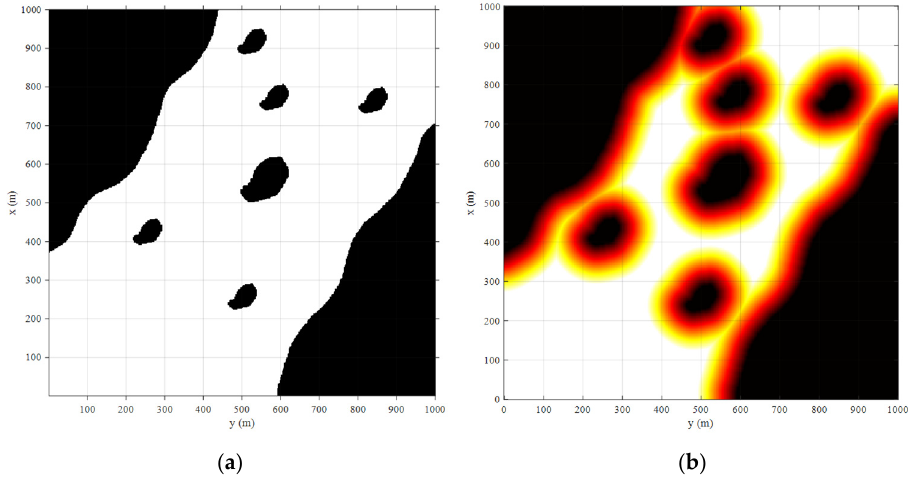
Figure 2. The binary map and a representation of the static scenario ( d = 100 m). ( a ) The binary map, ( b ) The static obstacle representation.